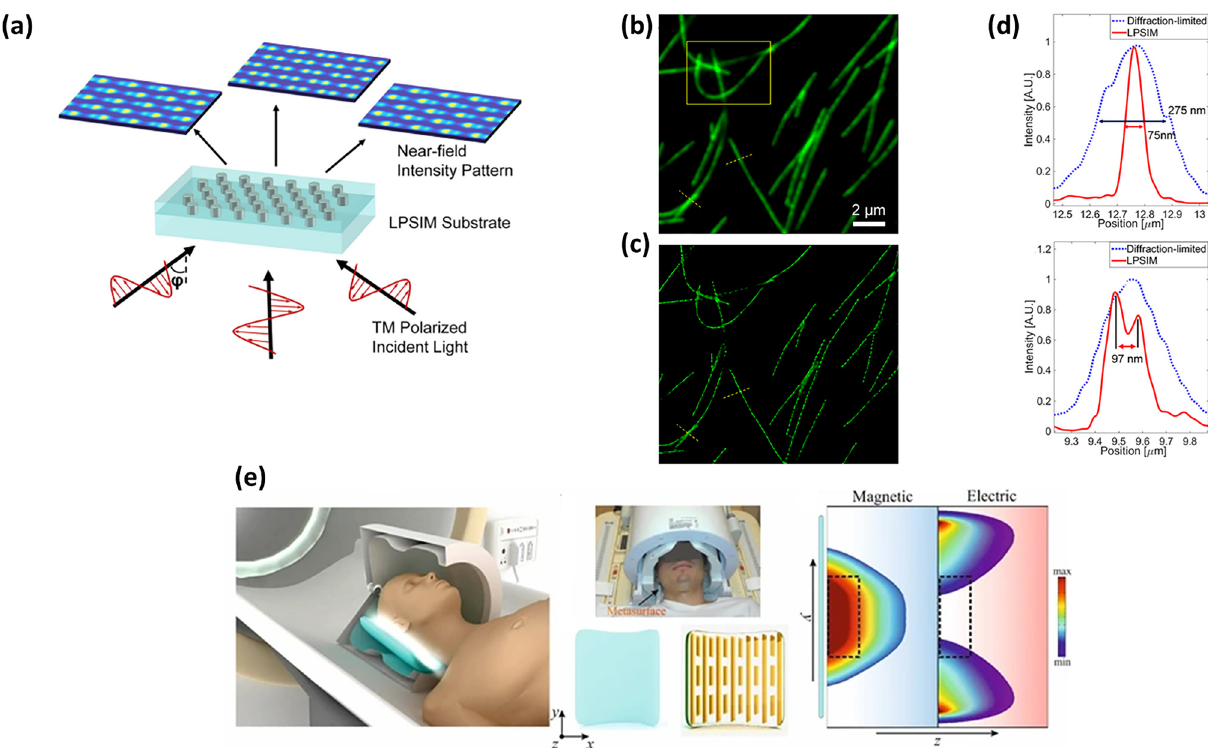
Figure3: (a) – (d):Super-resolutionimaging;(e)magneticresonanceimaging(MRI)imaging.(a)Near- fi eldintensitydistributionsgeneratedby the metasurface under the illumination of trasnverse-magnetic (TM)-polarized light at an angle of − 60 ° , 0 ° , and 60 ° , along the symmetry axes of the localized plasmonic structured illumination microscopy (LPSIM) substrate. (b) One frame of the video recording of green microtubules withdiffraction-limitedimagingand(c)withsuper-resolutionimaging.(d)Reducedfullwidthathalfmaximum(FWHM)ofthesuper-resolution imaging compared to diffraction-limited one along the two dashed yellow lines in (b) and (c). (a) – (d) Reproduced with permission from Bezryadina et al., ACS Nano 12 , 8248 – 8254 (2018) [109]. Copyright 2018 American Chemical Society. (e) Illustration and photograph of the experiment showing an MRI scan for a human brain with a metasurface consisting of a high permittivity dielectric pad and metallic stripes. Numerical simulation showing that metasurface can locally redistribute the magnetic fi eld and electric fi eld. (e) Reproduced with permission from Schmidt et al., Sci. Rep. 7 , 1678 (2017) [113]. Licensed under Creative Commons Attribution 4.0 International